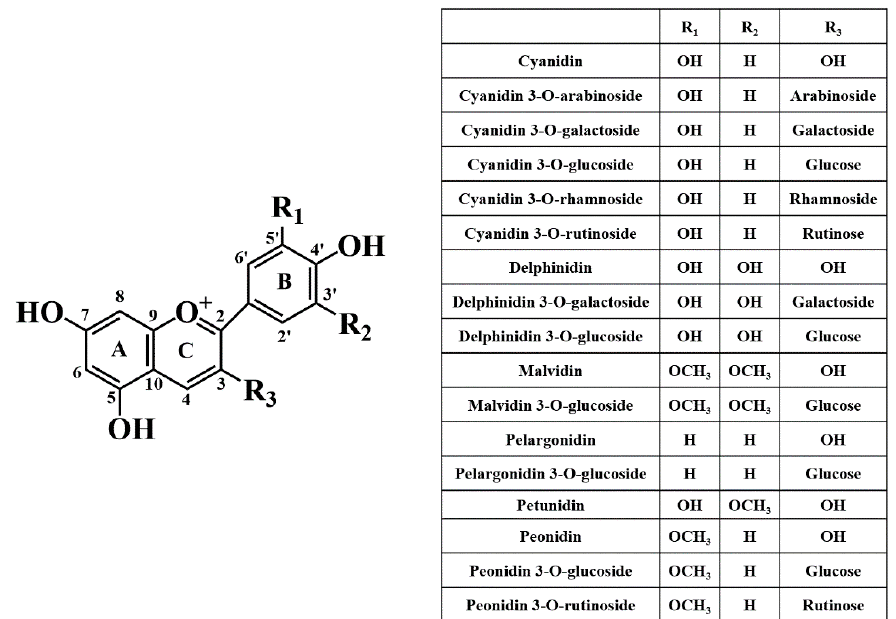
Figure 2. Basic chemical structure of the main anthocyanidins and their glycosides anthocyanins found in nature.